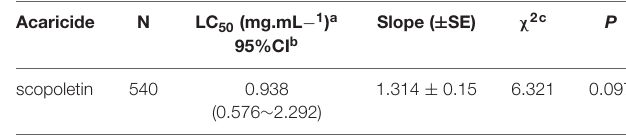
TABLE 1 | Toxicity of scopoletin against adult females of T. cinnabarinus after 48 h exposure